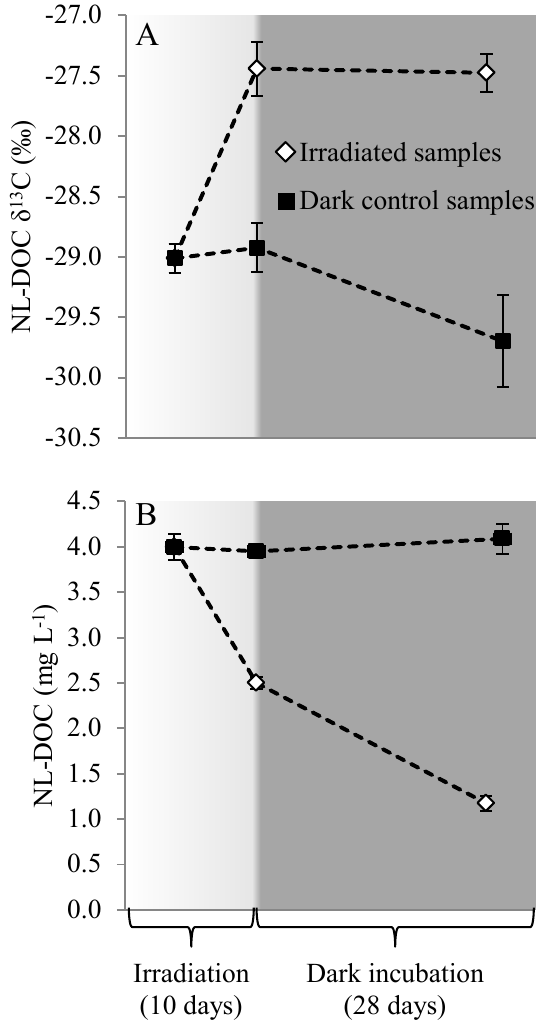
Figure 3. Concentration of NL-DOC and its δ 13 C value in a repre- sentative riverine sample (the Amazon River) during the 10-day abi- otic photooxidation and the following 28-day microbial degradation initiated by inoculation with unfiltered riverine water containing in- digenous bacteria. Irradiated samples are shown in white, while the dark controls are shown in